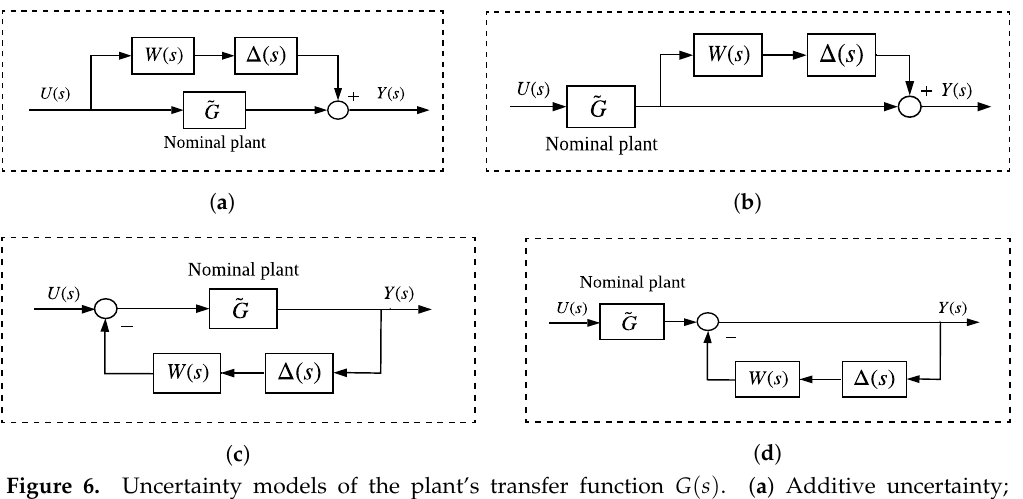
Figure 6. Uncertainty models of the plant’s transfer function G ( s ) . ( a ) Additive uncertainty; ( b ) Multiplicative uncertainty; ( c ) Feedback uncertainty; ( d ) Multiplicative feedback